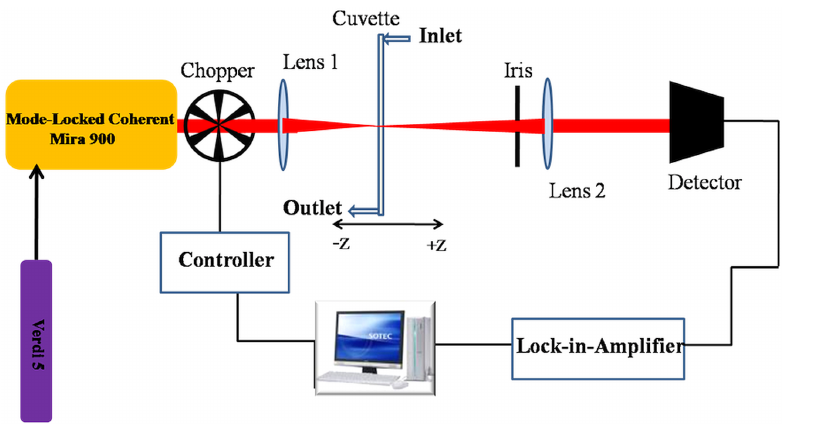
Figure 1 Schematic of experimental z-scan setup showing inlet and outlet for flowing liquids. Full-size DOI: